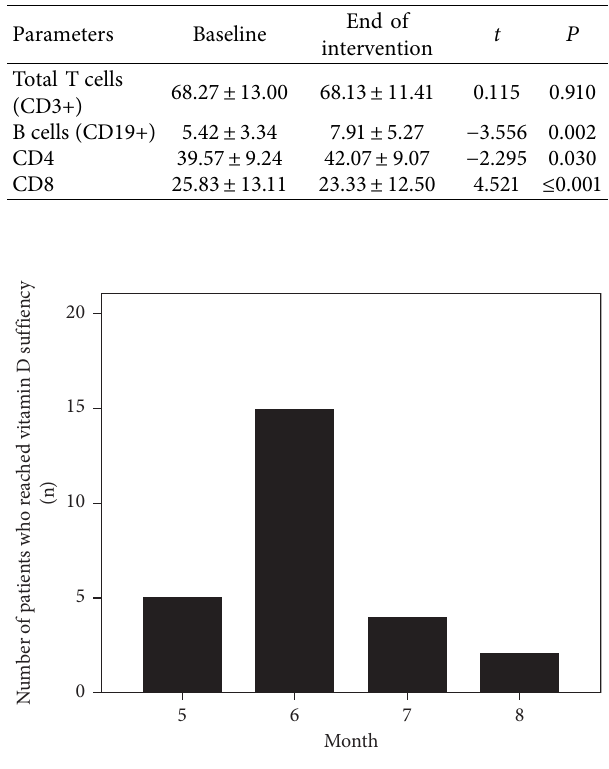
Figure 2: Number of patients and the time spent to reach vitamin D